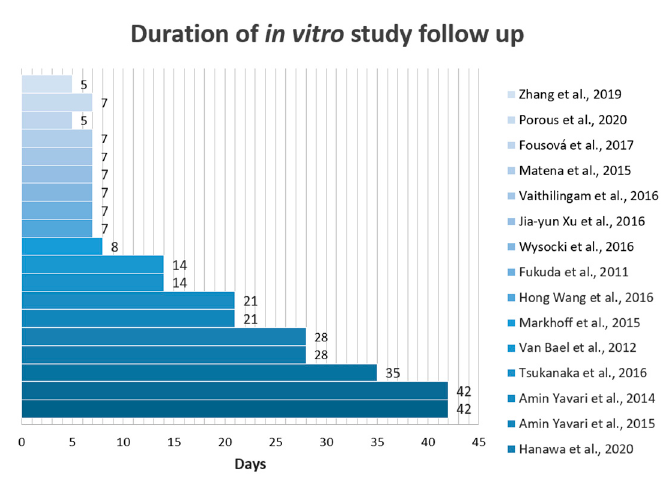
Figure 4. Duration of follow-up period of in vitro included studies.